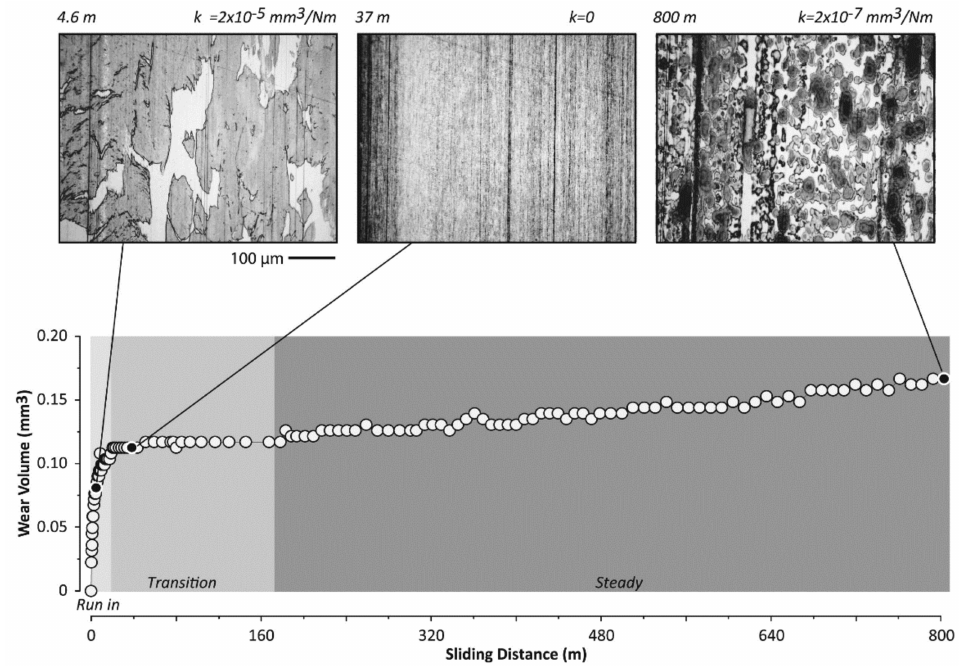
Figure 9. Micrographs of the transfer film morphology for run-in, transition and steady-state phases, corresponding to the graph of wear volume against sliding distance (Reproduced with permission from J. Ye, H. S. Khare, D. L. Burris, Wear; published by Elsevier, 2013) [106].